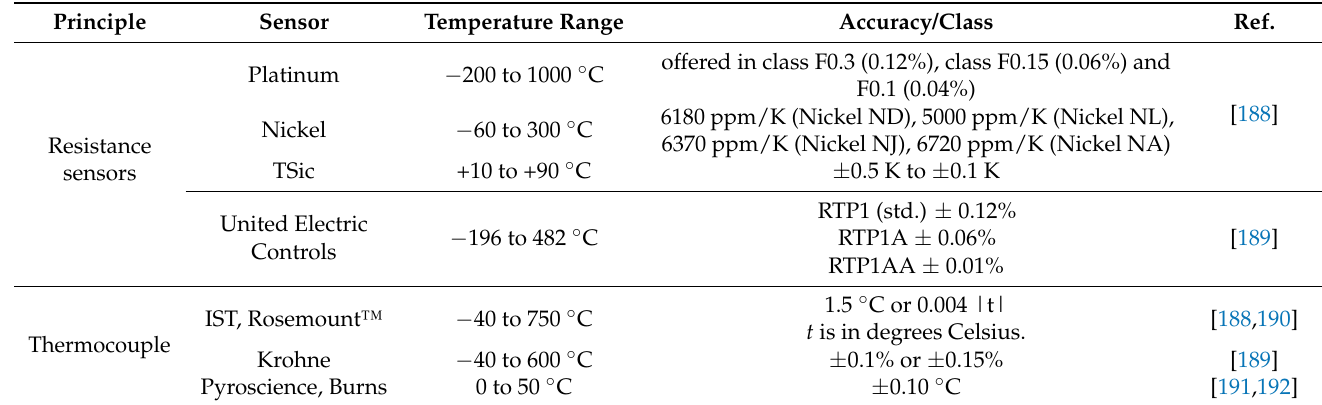
Table 2. Commercially available temperature